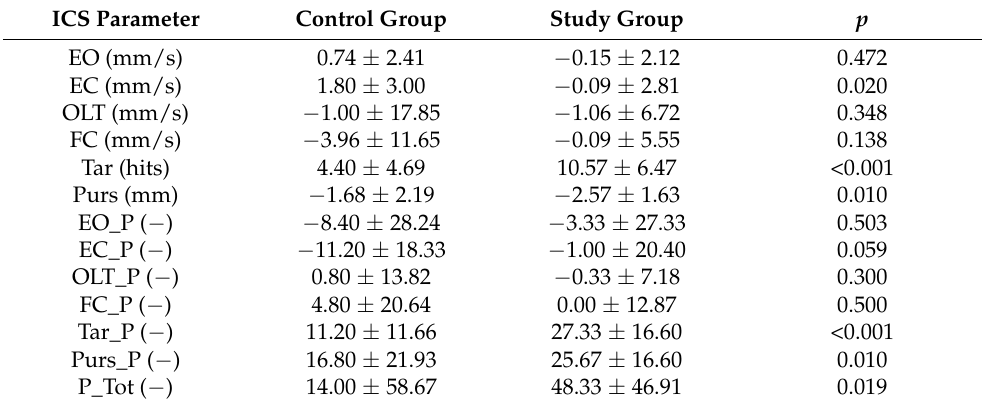
Table 1. Differences between the study and control groups before and after the intervention.